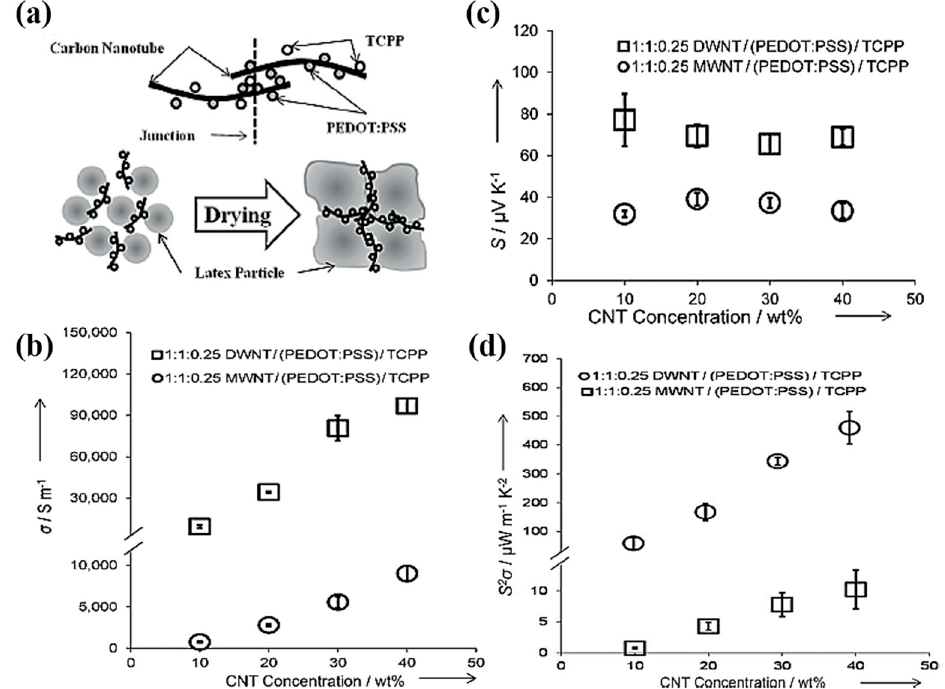
Figure 8. ( a ) top: the schematic of double walled carbon nanotubes (DWNT) coated by PEDOT:PSS and TCPP molecules and the junction formed between them. Bottom: schematic of the formation of a segregated network composite during polymer coalescence as it dries, ( b ) electrical conductivity, ( c ) seebeck coefficient, and ( d ) power factor as a function of CNT concentration and type. Reprinted with permission from [64]. Copyright 2013 John Wiley and Sons.